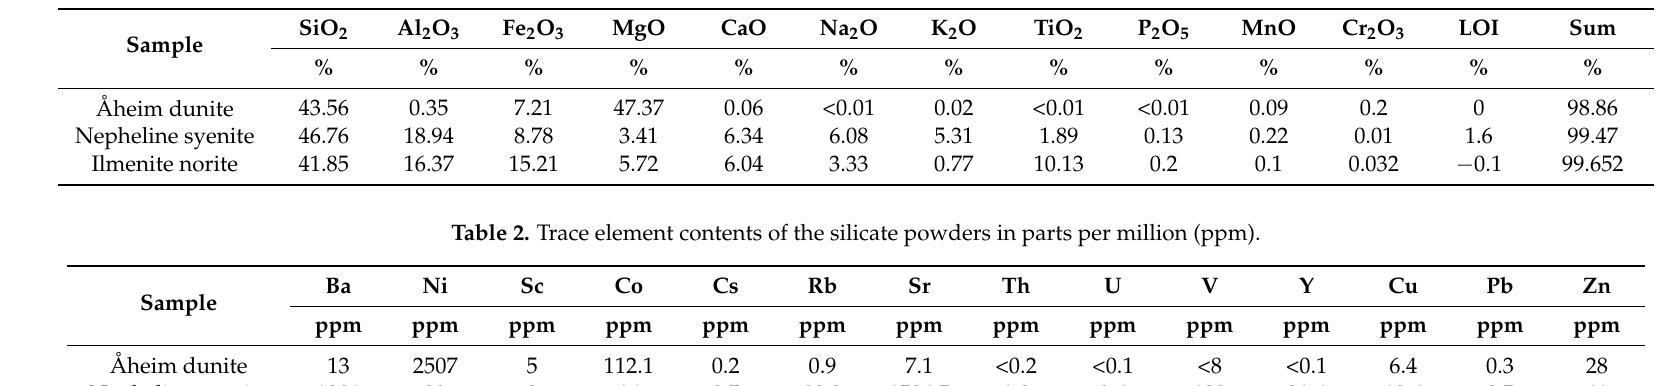
Table 1. Major element bulk chemical compositions of the silicate powders.